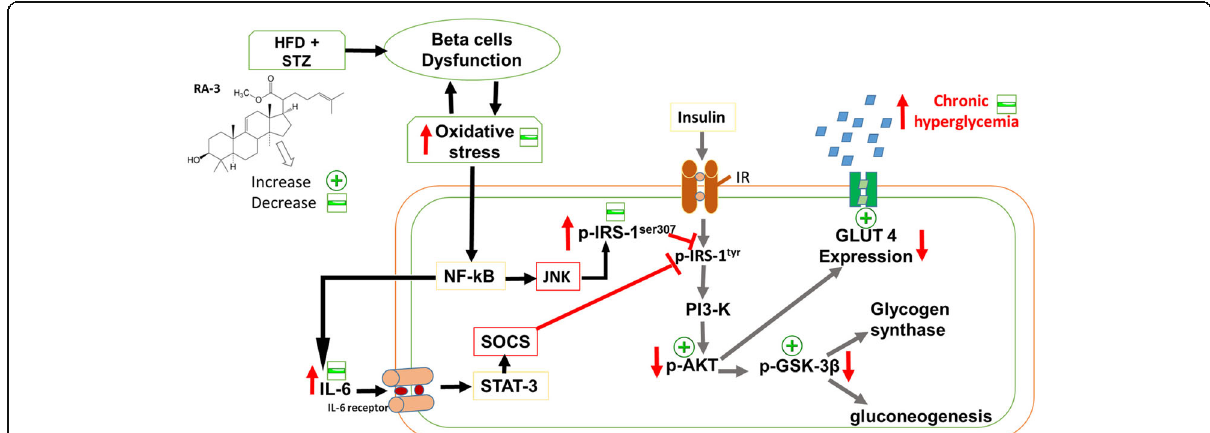
Fig. 5 Overview of insulin regulation of major metabolic responses in the cells. Under physiological conditions, insulin binds to its receptor (IR) to enhance positive tyrosine IRS-1 phosphorylation, promoting the activation of PI3-K which in turn phosphorylates and activates p-Akt. High expression of p-Akt activates translocation of glucose transporter 4 and thus increasing glucose uptake by the cell. p-Akt also further phosphorylates GSK-3 β , promoting the glucose storage as glycogen. Under pathophysiological conditions, oxidative stress and pro-inflammatory cytokines such as IL-6 enhance negative phosphorylation of IRS-1 serine (307) , causing insulin resistance. Activated NF- K B activates serine/threonine kinases (JNK) which phosphorylates IRS-1 and also works via other pathways such as SOCS expression to inhibit the insulin signaling